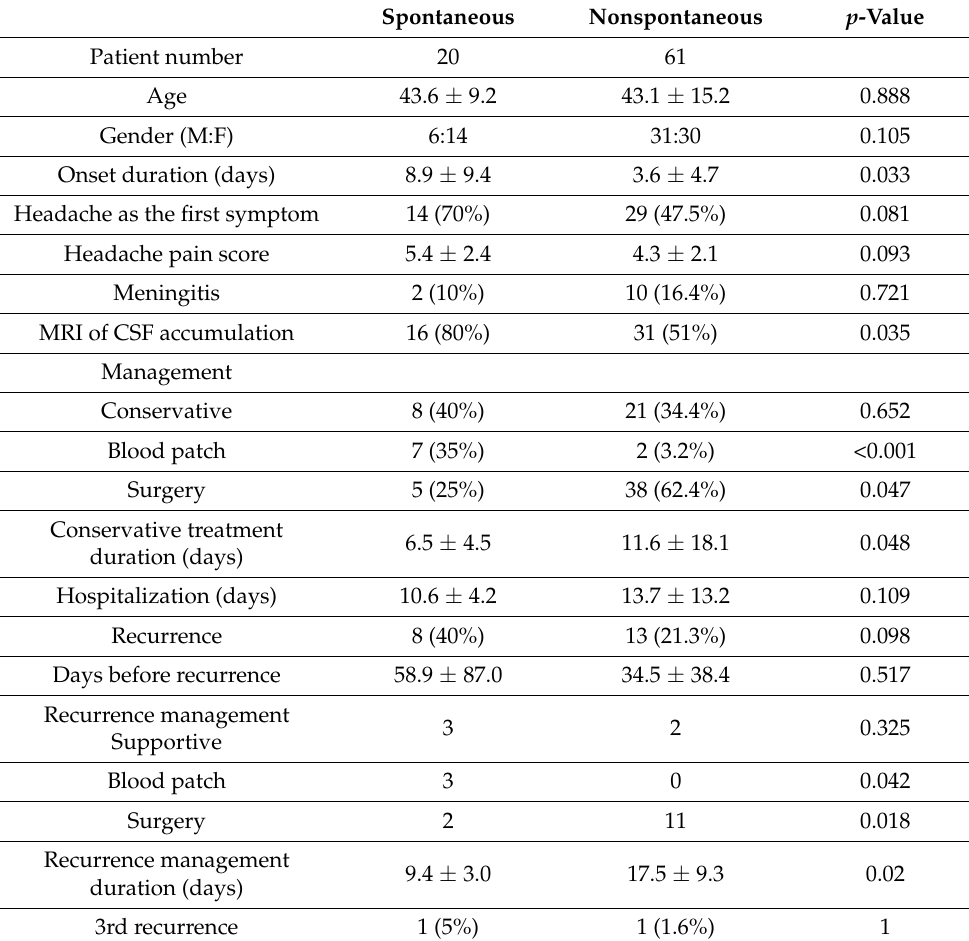
Table 1. Demographic data of spontaneous and nonspontaneous CSF leak. Spontaneous Nonspontaneous p -Value